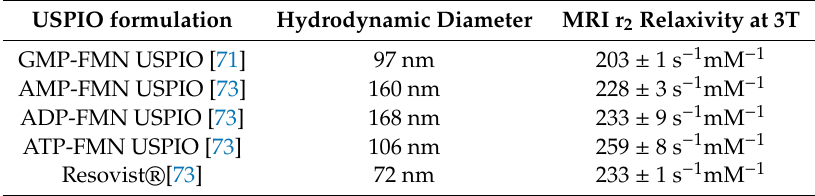
Table 4. Properties of di ff erent USPIO.